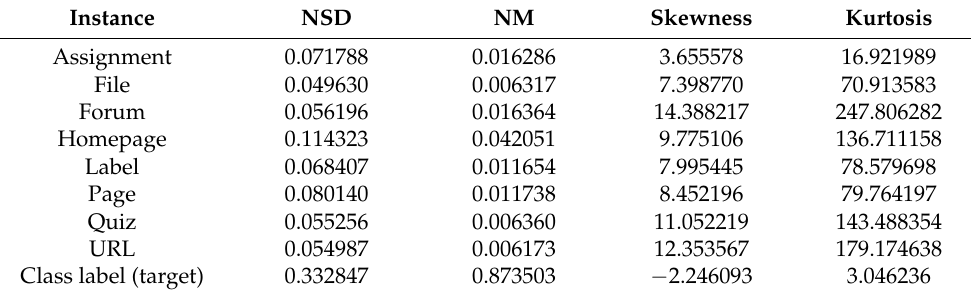
Table 2. The evaluated data sets and their characteristics.